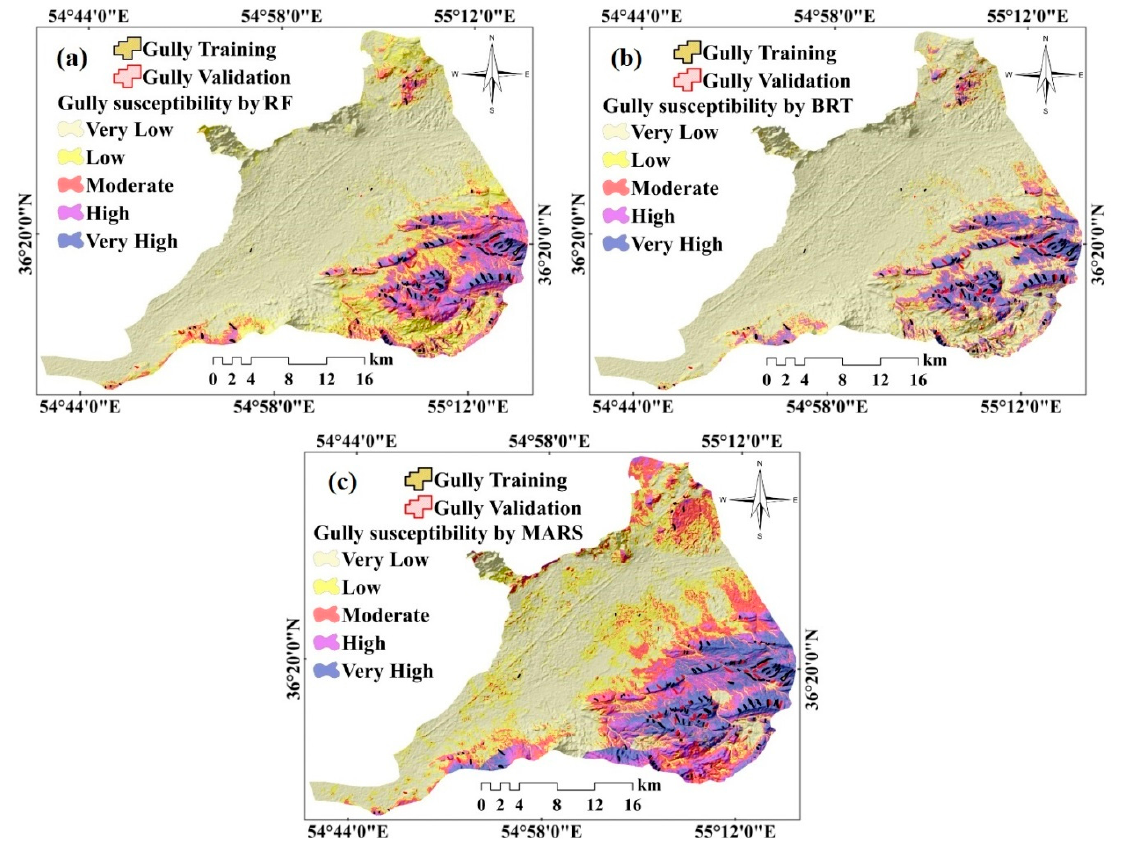
Figure 5. Gully erosion susceptibility maps using: ( a ) RF model, ( b ) BRT model, and ( c ) multivariate adaptive regression spline (MARS) model.